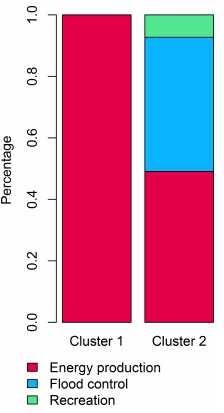
Figure 10. Reservoir purpose mix of catchments in regulation clus- ters 1 and 2 (see Fig. 9), including energy production, flood control, and recreational